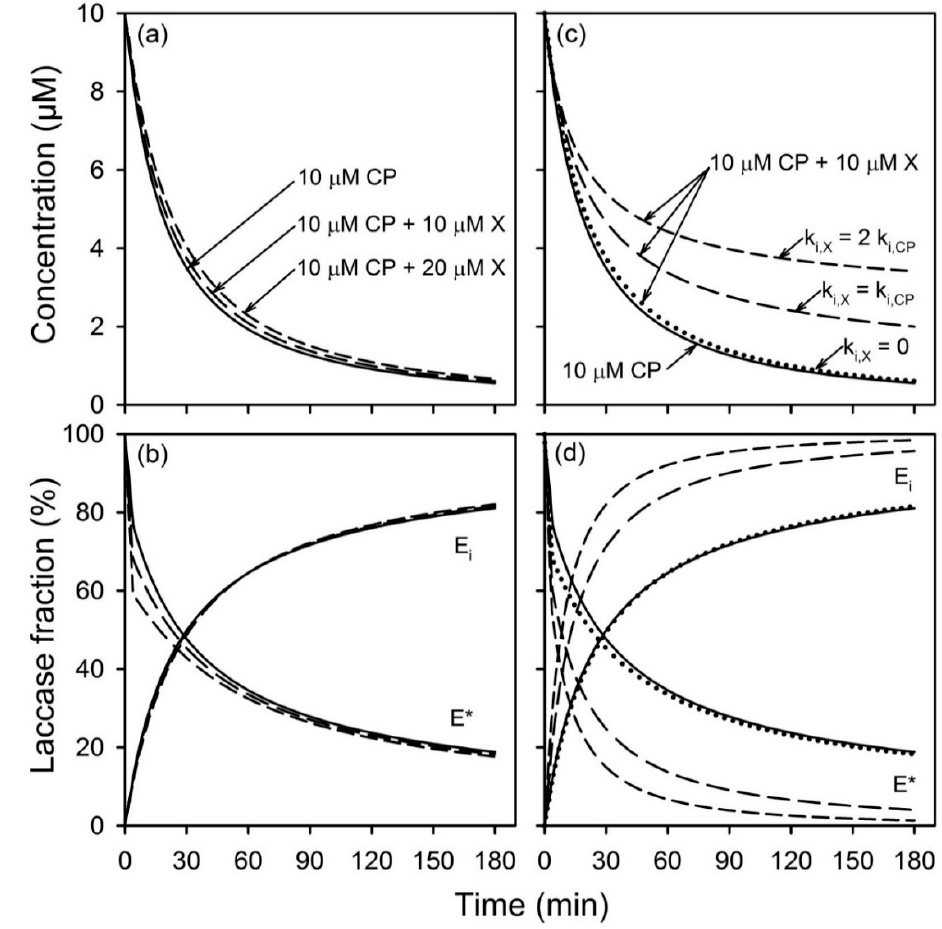
Figure A2. Predicted impacts of a hypothetical secondary substrate, X, on the kinetics of oxidation of the target substrate, cumylphenol (CP), and the corresponding fractions of laccase in the oxidized, E*, and inactivated, E i , states over time: ( a,b ) effect of varying the initial concentration, [S X ] 0 , of the secondary substrate, X, when it is non-inactivating (i.e., 𝑘 (cid:3036) = 0); ( c,d ) effect of varying the inactivation rate constant, 𝑘 (cid:3036) , of the secondary substrate, X, for a fixed initial secondary substrate concentration, [S X ] 0 , of 10 μ M. For all simulations, the initial concentration of the target substrate was 10 μ M and the total enzyme supplied to the reaction, [E t ] , was 26 nM. The fractions of enzyme in the E* and E i states over time are expressed as a percentage of the total enzyme, [E t ] . The fraction of enzyme in the native state, E, is not shown.